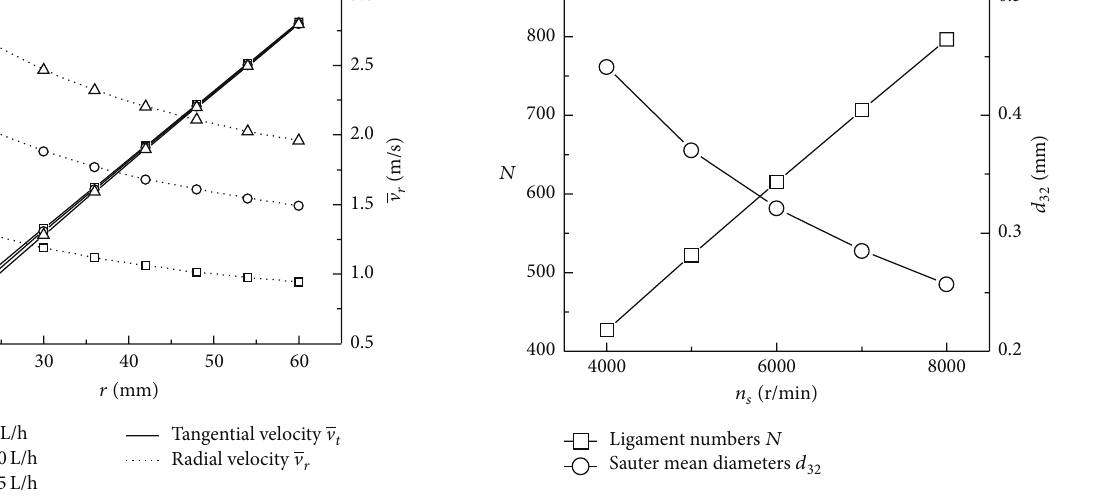
Figure 12: Influence of oil volume flow rate on oil film velocity.